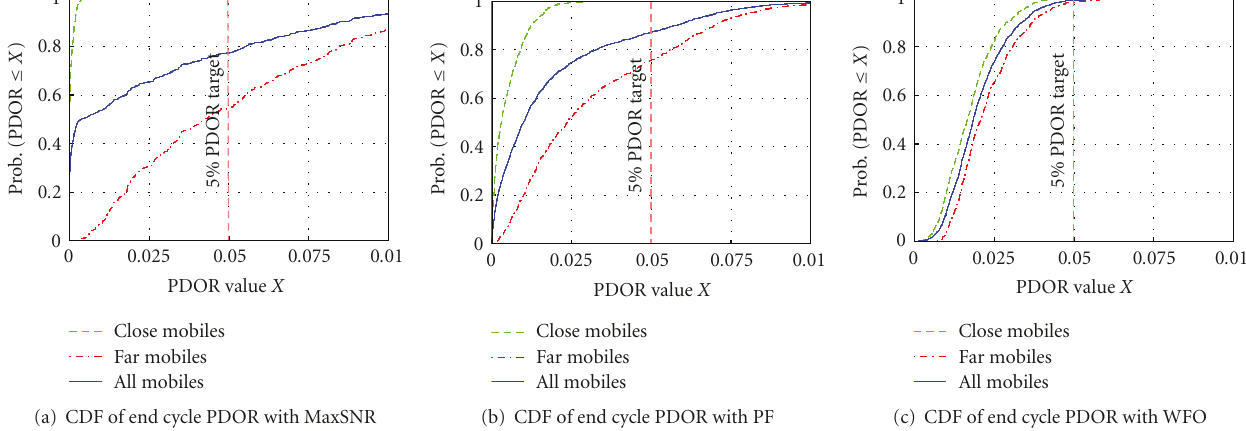
Figure 9: Perceived QoS with di ff erent allocation schemes.